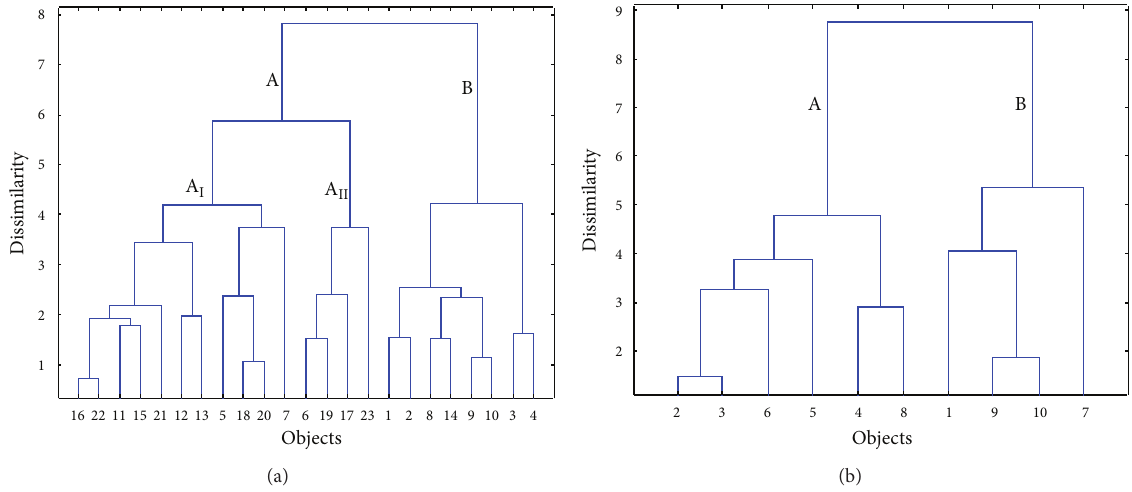
Figure 2: Dendrograms of (a) sampling sites in the space of 10 measured parameters and (b) variables in the objects space.